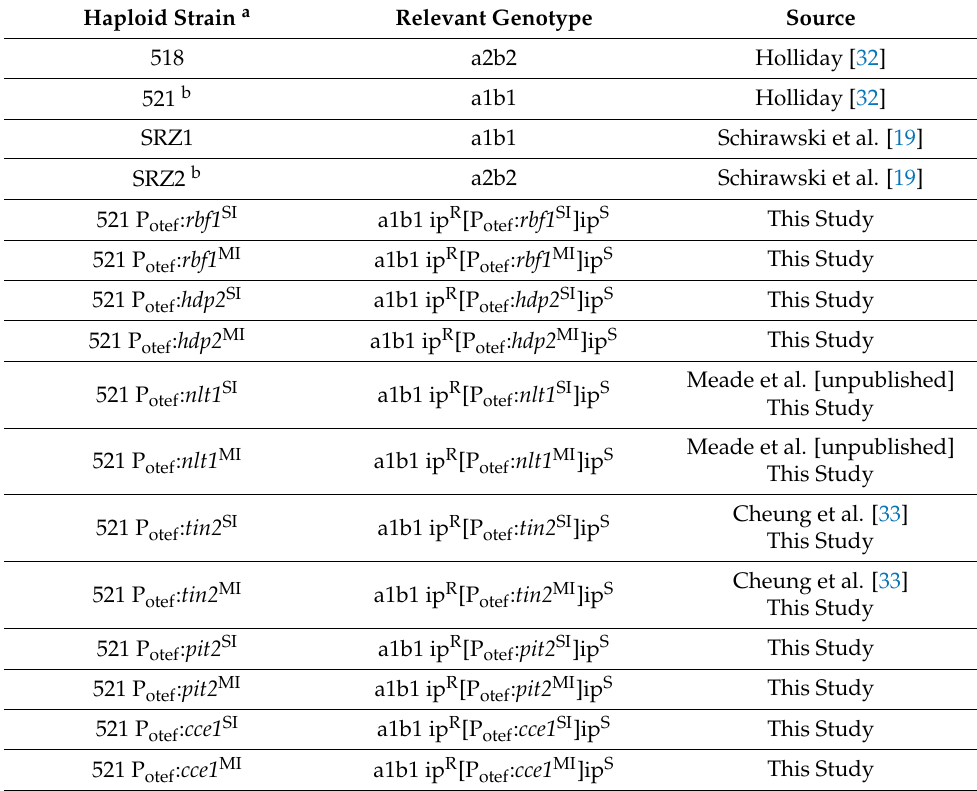
Table 1. Fungal strains used in this